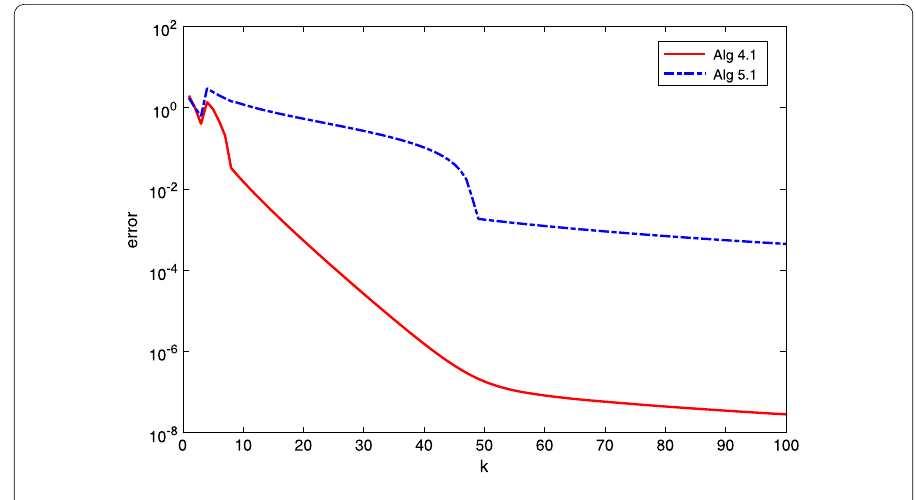
Figure 3 Comparison of Algorithms 4.1 and